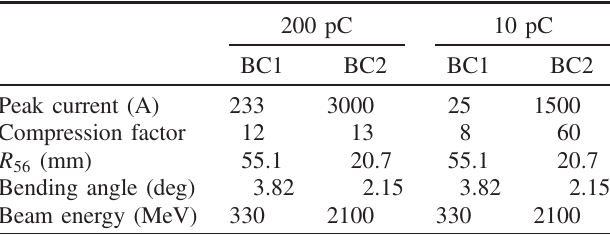
TABLE I. Peak currents at the exit of the first (BC1) and the second (BC2) bunch compressor and compression factors cor- responding to the maximum and the minimum bunch charge foreseen at SwissFEL. The peak currents at the entrance of BC1 are 20 and 3 A for the 200 and 10 pC bunch charge cases, respectively.